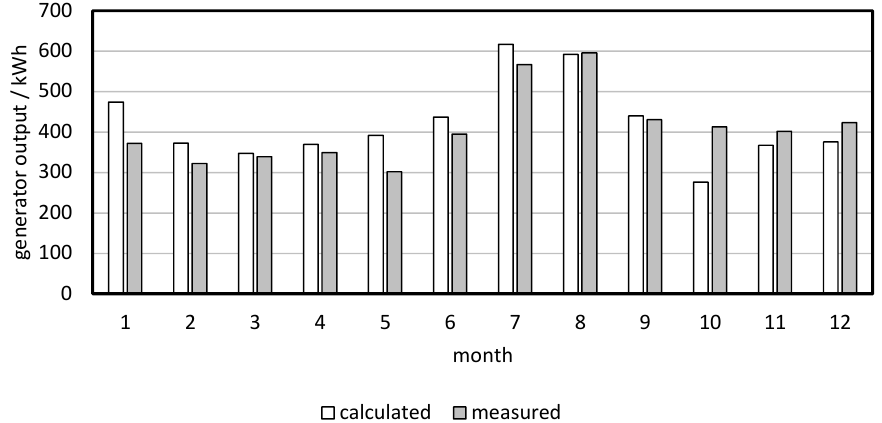
Figure 13. Measured and calculated monthly generator output for the SOPE.